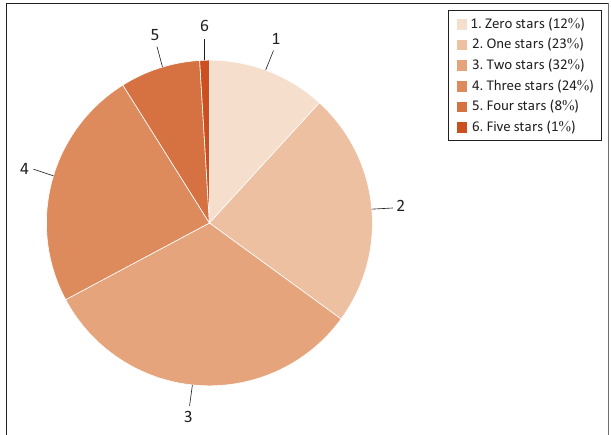
FIGURE 3: Percentage of laboratories per star rating, of a total of 314 laboratories, retrieved from Stepwise Laboratory Quality Improvement Process towards Accreditation database on 24 April 2019.